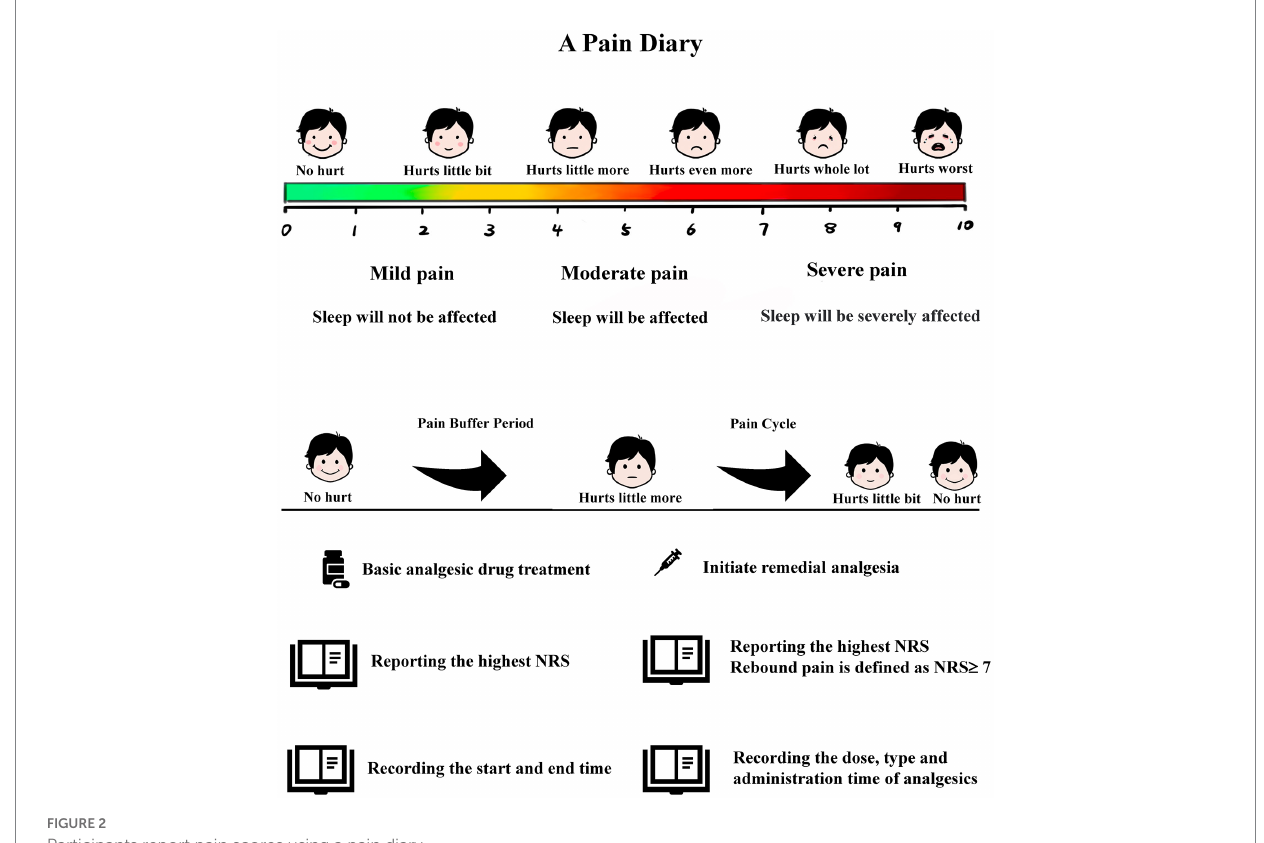
FIGURE 2 Participants report pain scores using a pain